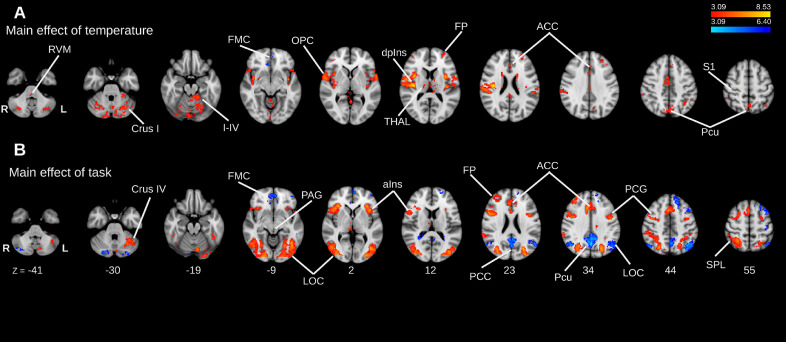
Whole brain main effect analyses in the pooled cohort (N = 57). Positive (red/yellow) and negative (blue/light-blue). Data was obtained from cluster-based thresholding using an initial threshold of Z > 3.09 and FWE corrected p < 0.05, one-sample t-test.(A)Main effect oftemperature. Positive activation in the high temperature conditions was found in anterior cingulate cortex (ACC), thalamus (THAL), dorsal posterior insula (dpIns), precuneus (Pcu), primary somatosensory cortex (S1) and rostroventromedial medulla (RVM). Activation in the negative main effect of temperature (low temperature vs high temperature) was observed in the frontal medial cortex (FMC).(B)Main effect oftask. Activity in the positive main effect was found in the anterior insula (aIns), lateral occipital cortex (LOC), ACC, superior parietal lobule (SPL). Activity in the negative main effect was found in the frontal pole (FP), posterior cingulate cortex (PCC) and Pcu.